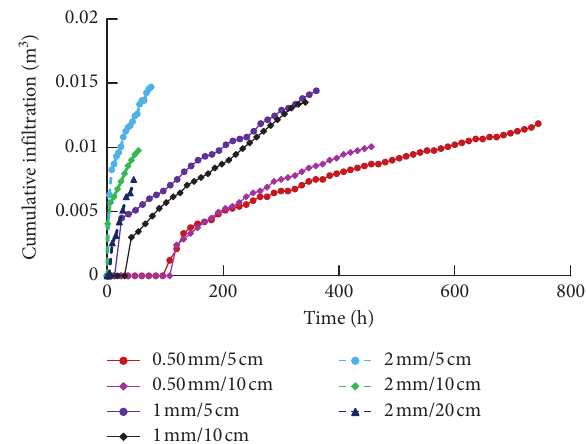
Figure 8: Relationship curve between cumulative infiltration volume and infiltration time.